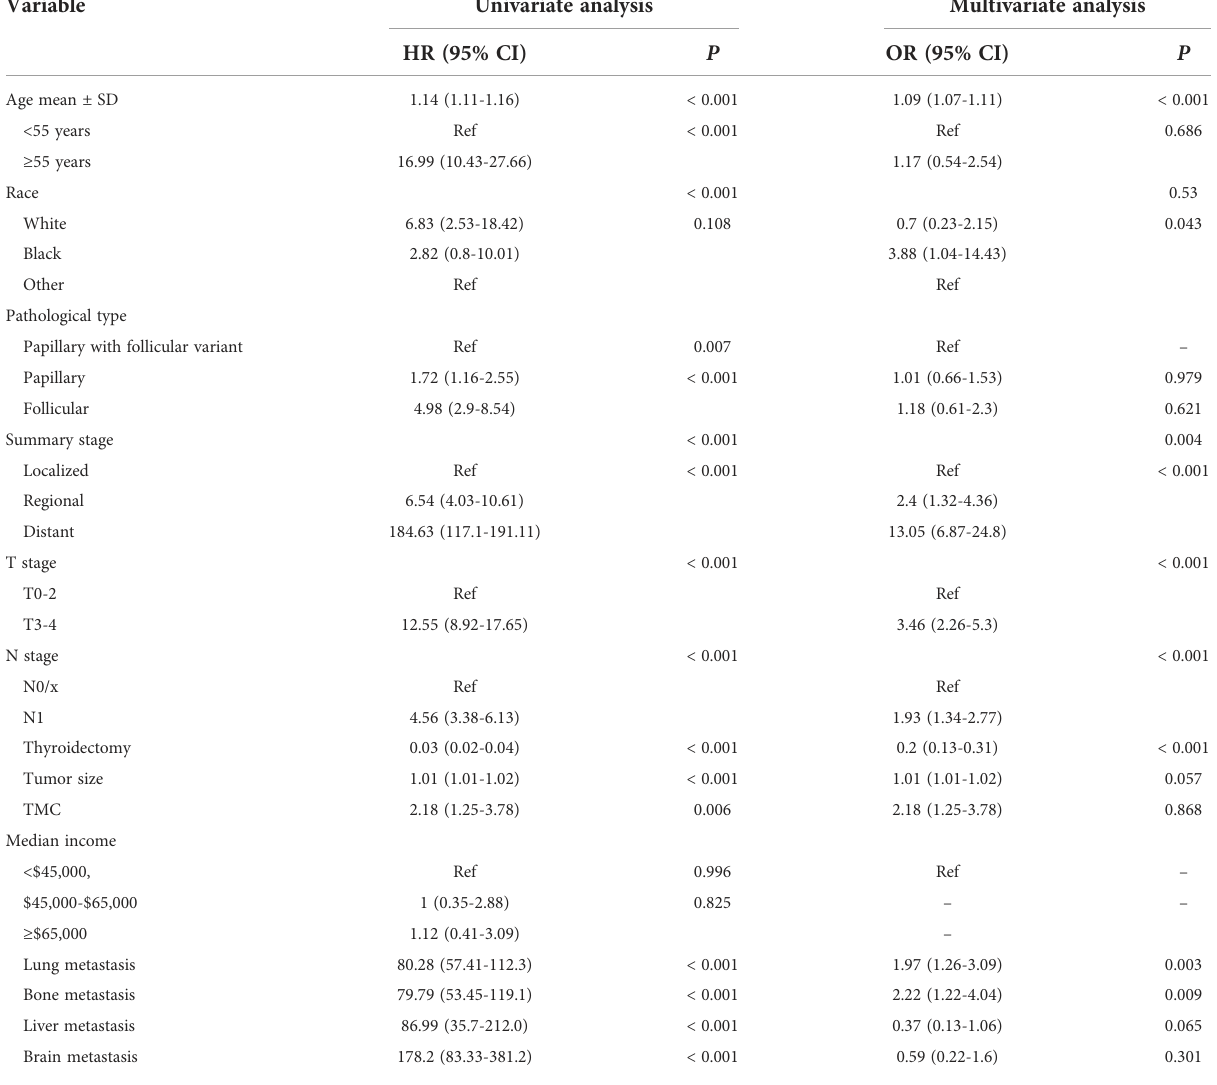
TABLE 6 Univariate and multivariate cox regression analyses of the prognostic factors of CSS in FDTC patients.